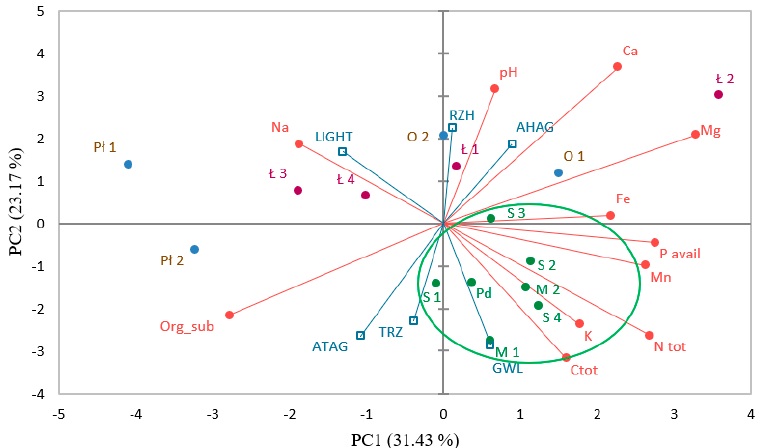
Figure 5. Results of the principal component analysis: blue—potential lake sites; green—potential wetland sites; red—current lake sites. The abbreviations of the names of the objects as they appear in the tables: RZH—root zone humidity; AHAG—air humidity above the ground; ATAG—air temperature above ground; TRZ—temperature in the root zone; GWL—groundwater level; LIGHT— light; Pł—Płotycze lake; O—Orchowe lake; S—Stulno lake; M—Macoszyn lake; Pd—Podlaski lake; Ł—Łukietek